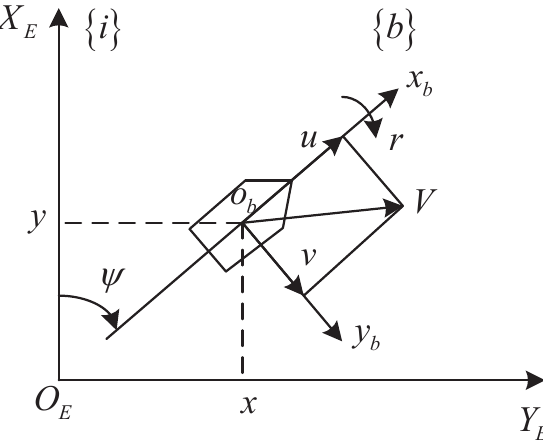
Figure 1. The earth-fixed inertial and the body-fixed